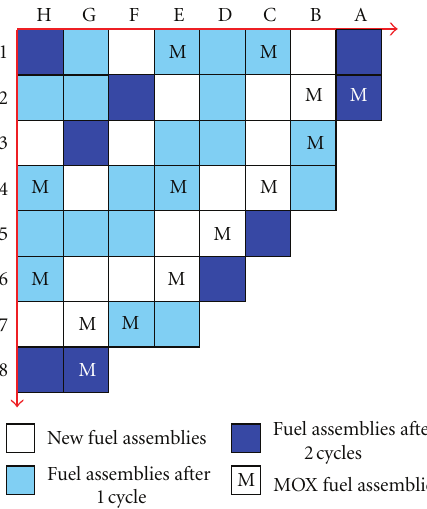
Figure 4: The loading pattern of fuel assemblies in the PWR.